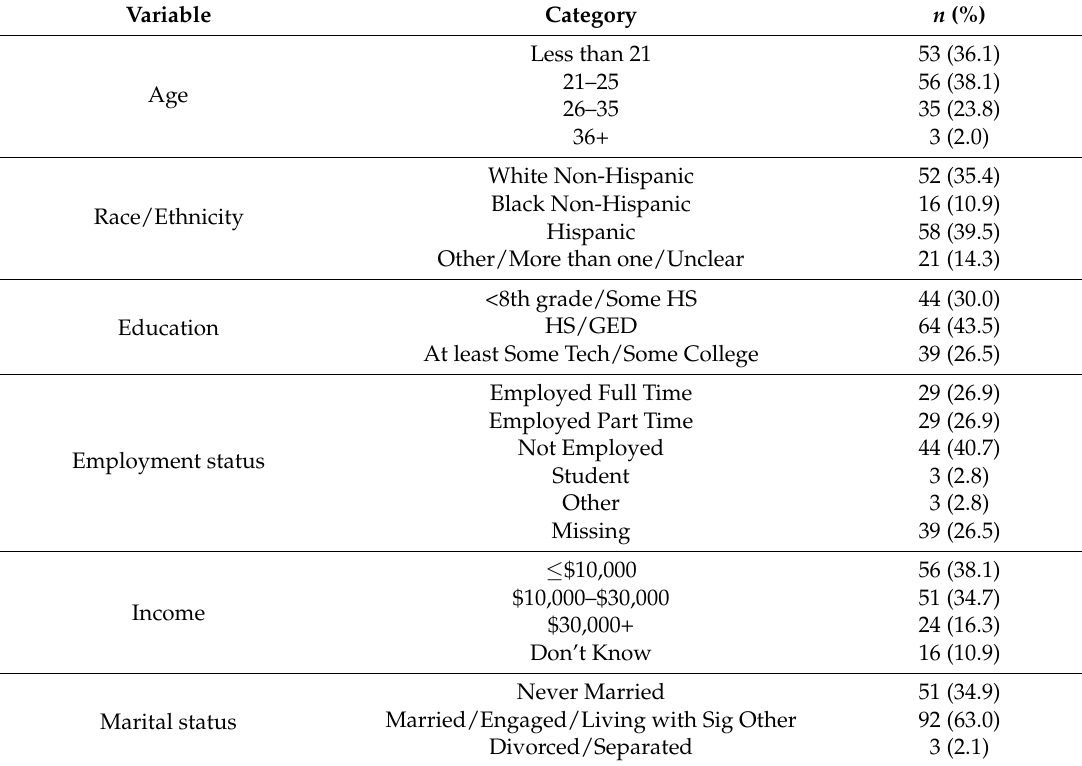
Table 1. Demographic Characteristics of the 34-Week Sample ( n =